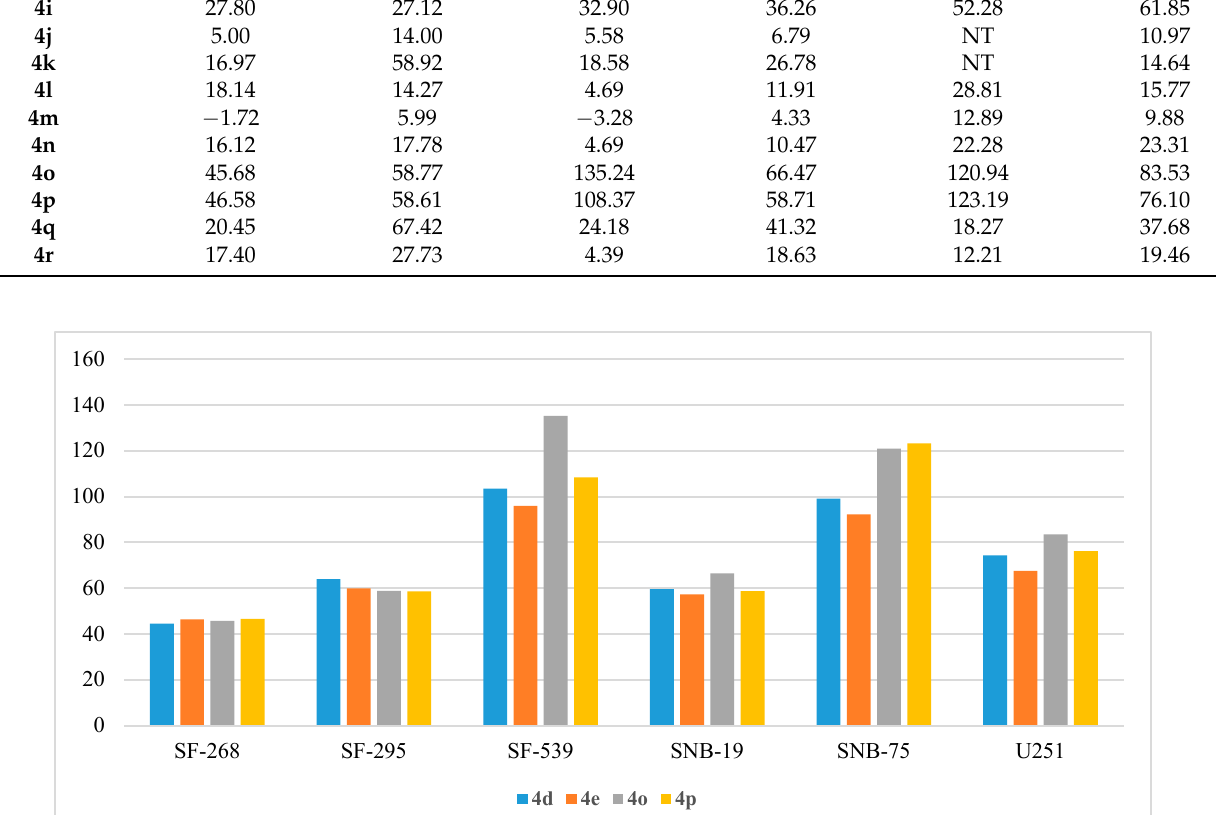
Figure 8. Anti-proliferative activities (% GI) of compounds 4d , 4e , 4o , and 4p against CNS cancer cell lines.